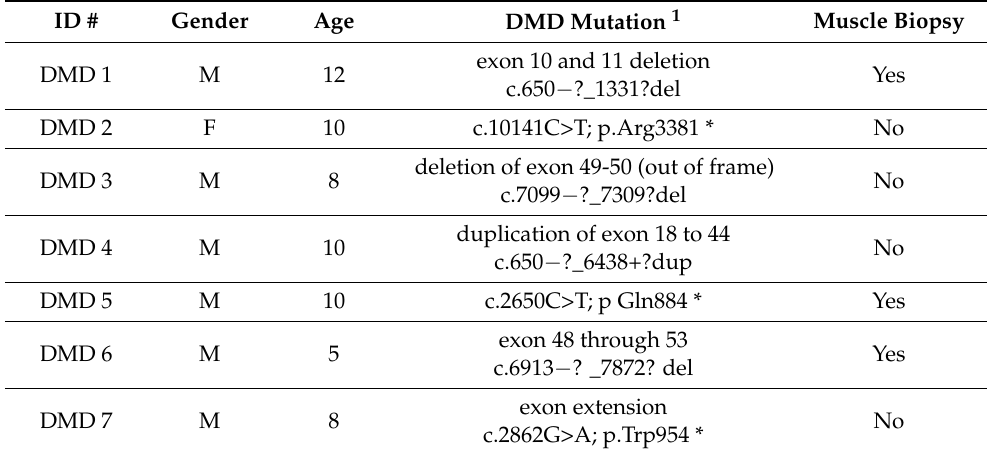
Table 6. DMD patients’ demographic